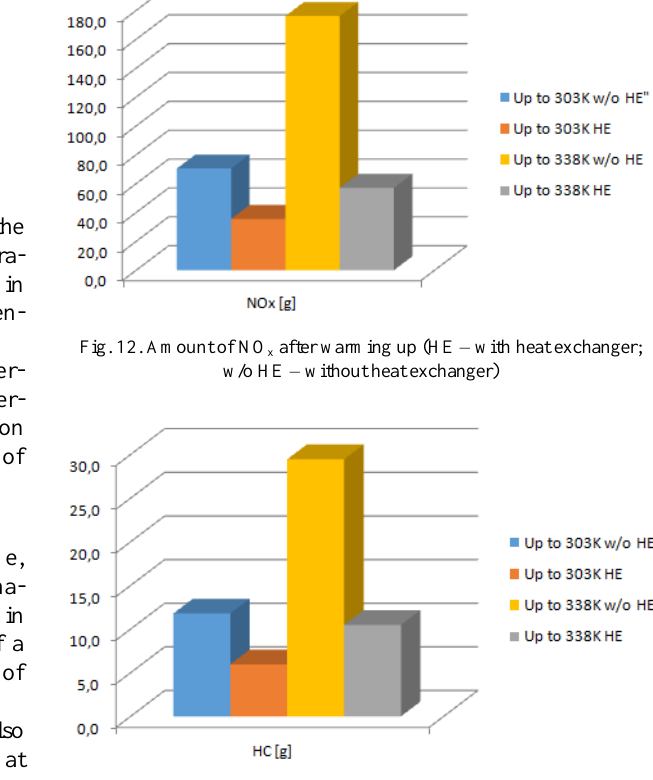
Fig. 13. Amount of HC after warming up (HE – with heat exchanger; w/o HE – without heat exchanger)